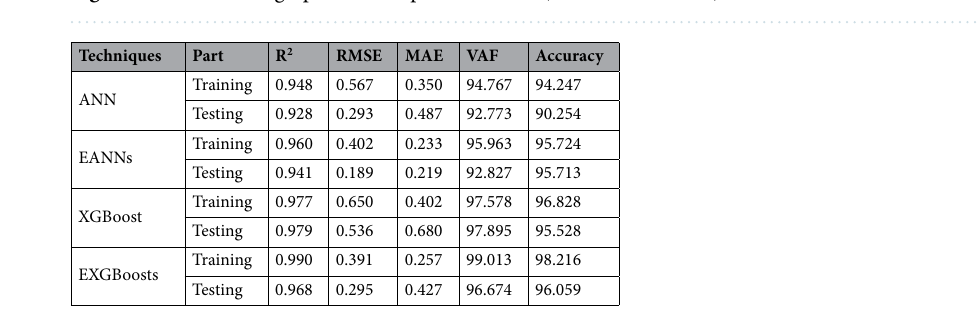
Figure 8. Correlation graph between predicted data (EXGBoosts model) and measured data.